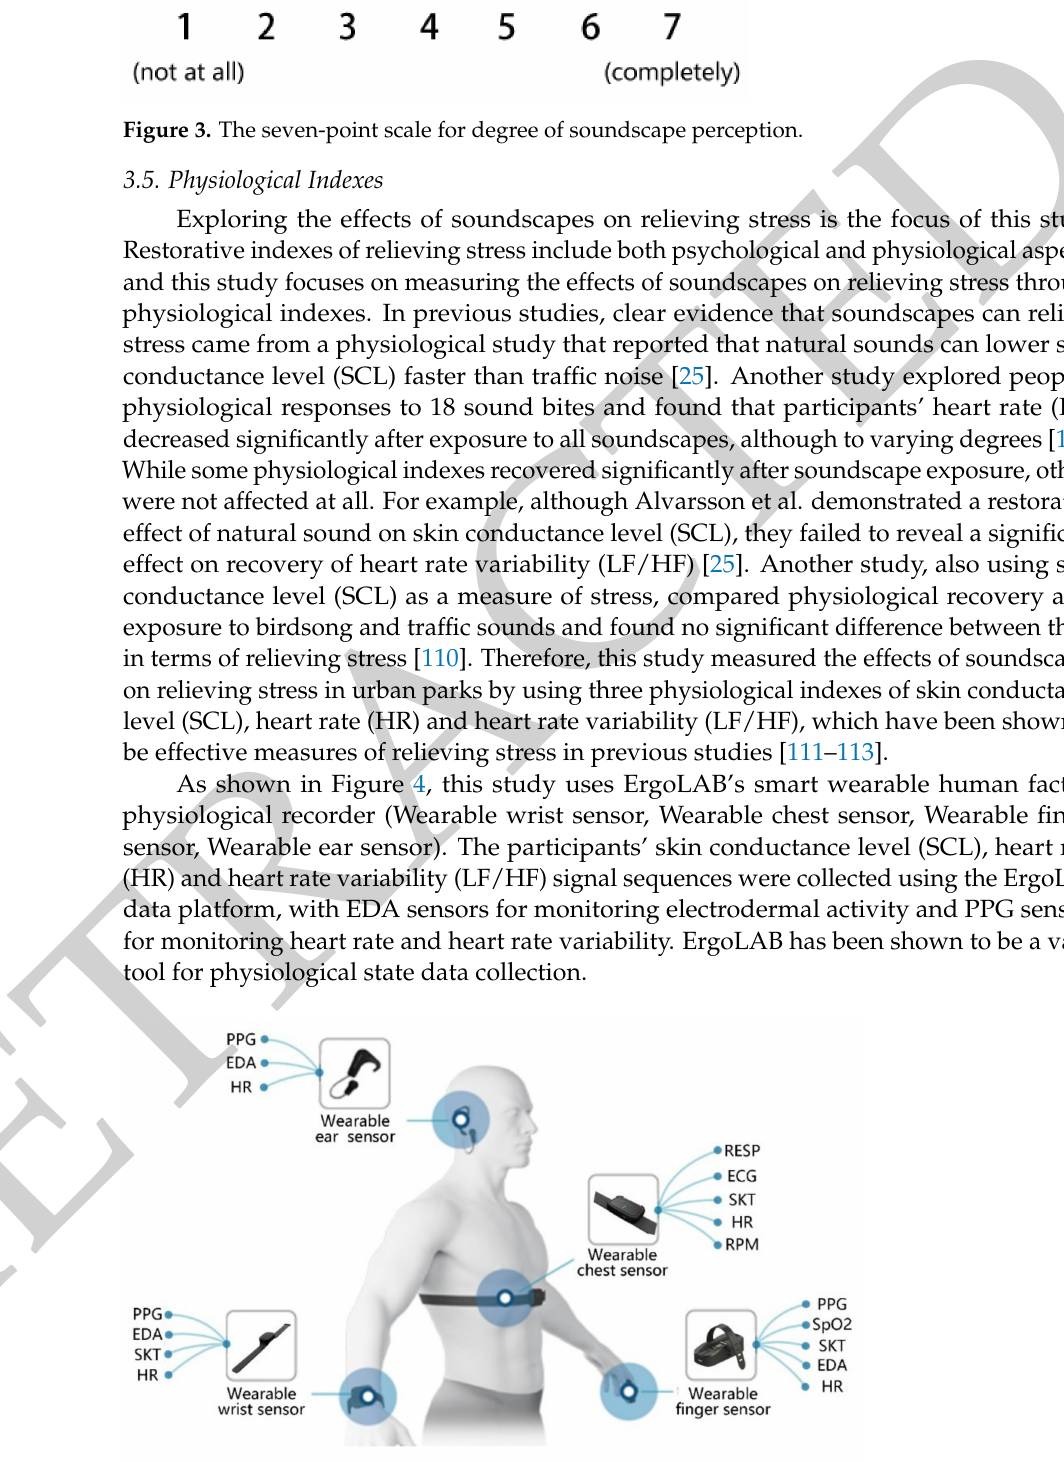
Figure 4. Display diagram of the smart wearable human factors physiology